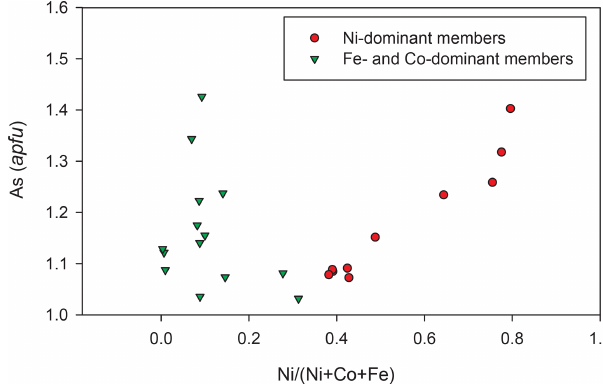
Figure 9. The Ni / (Ni + Co + Fe) vs. As (apfu) graph for sul- farsenides from the grimmite-bearing association from